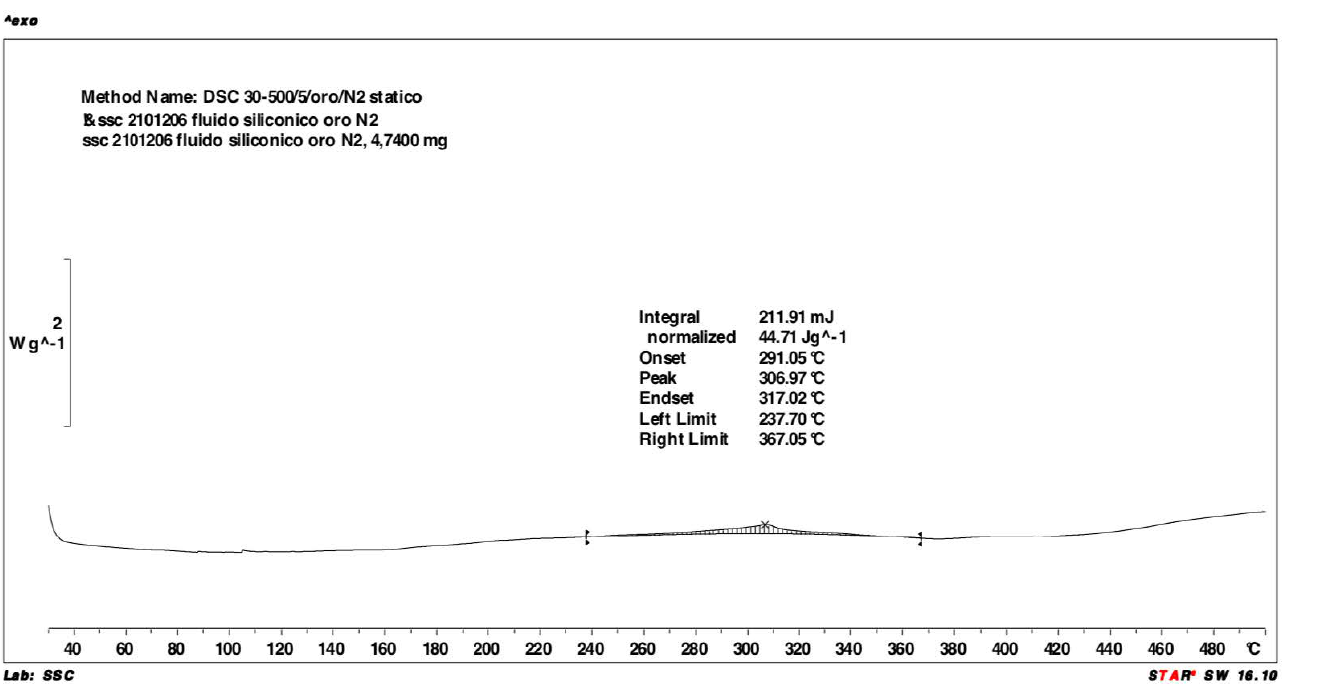
Figure 1. Results of DSC for MM samples in a gold-plated stainless steel container, in a nitrogen atmosphere.